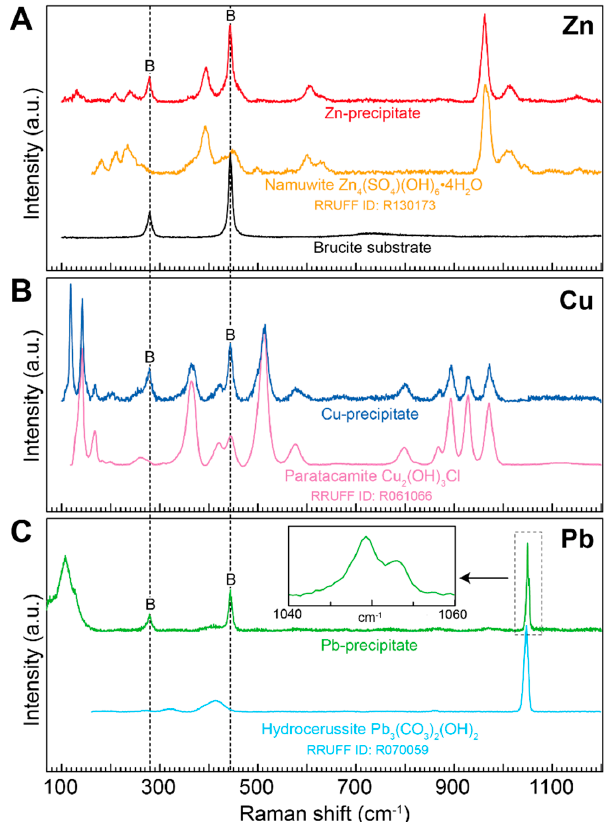
Figure 5. Raman spectra of surface precipitates formed after 36 h in ( A ) 10 mmol/L ZnSO 4 , pH 4.5; ( B ) 10 mmol/L CuCl 2 , pH 4.5; and ( C ) 1 mmol/L PbCl 2 , pH 4.5. The shown spectra are representative of the micrometer sized crystals in Figure 4A,E,F, respectively. The black spectrum in ( A ) corresponds to a pristine brucite surface. The peaks belonging to the underlying brucite substrate (marked “B”) are present in all of the measured spectra. The spectra of the Zn-, Cu-, and Pb-precipitates show good agreement with the reference spectra for namuwite, paratacamite, and hydrocerussite,